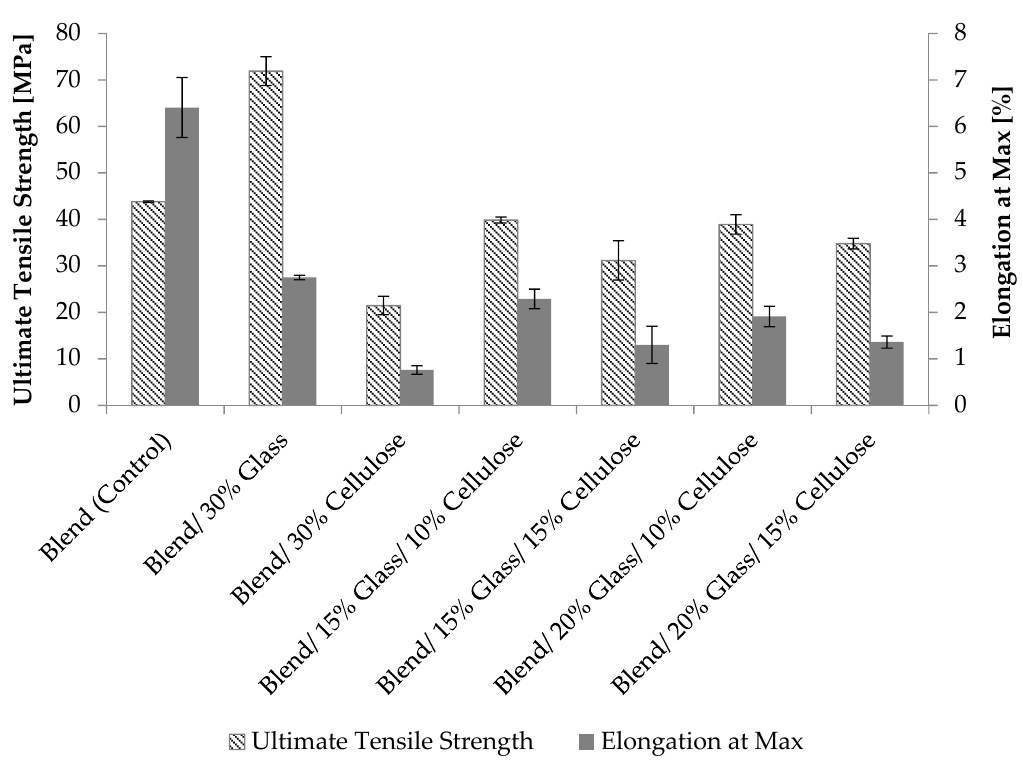
Figure 1. Tensile strength and elongation at maximum load of unfilled polymer blends and cellulose + glass fiber hybrid reinforced composites.